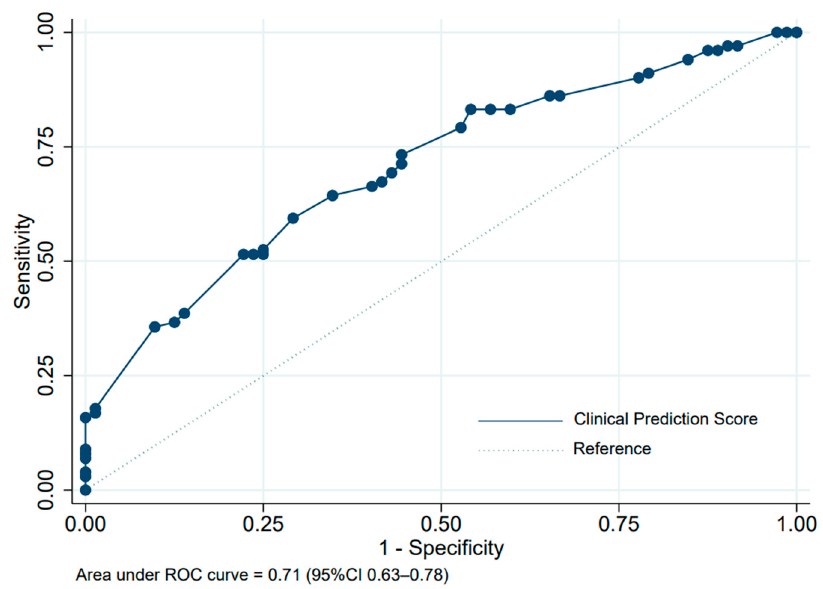
Figure 2. Performance of the clinical prediction score, area under the receiver operating characteristics (ROC) curve.